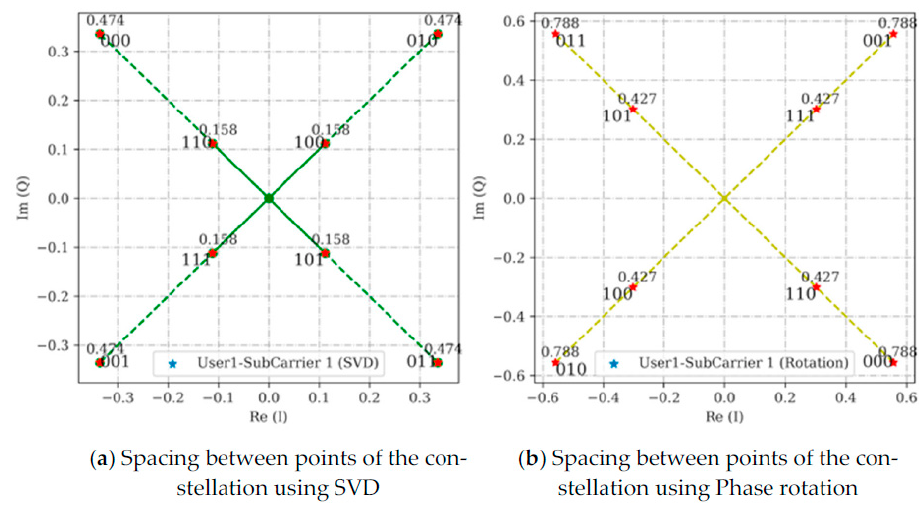
Figure 1. Minimum distance between points of the mother constellation.